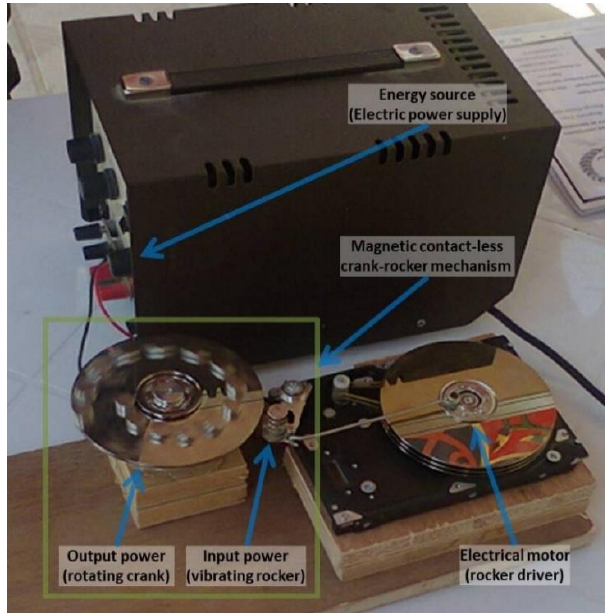
Figure 8. Simple demo structure of crank-rocker